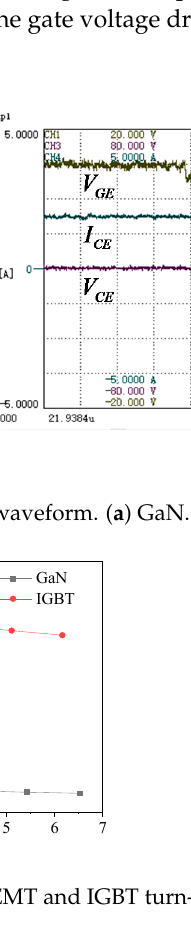
Figure 8. Experimentally measured GaN HEMT and IGBT turn-off time.